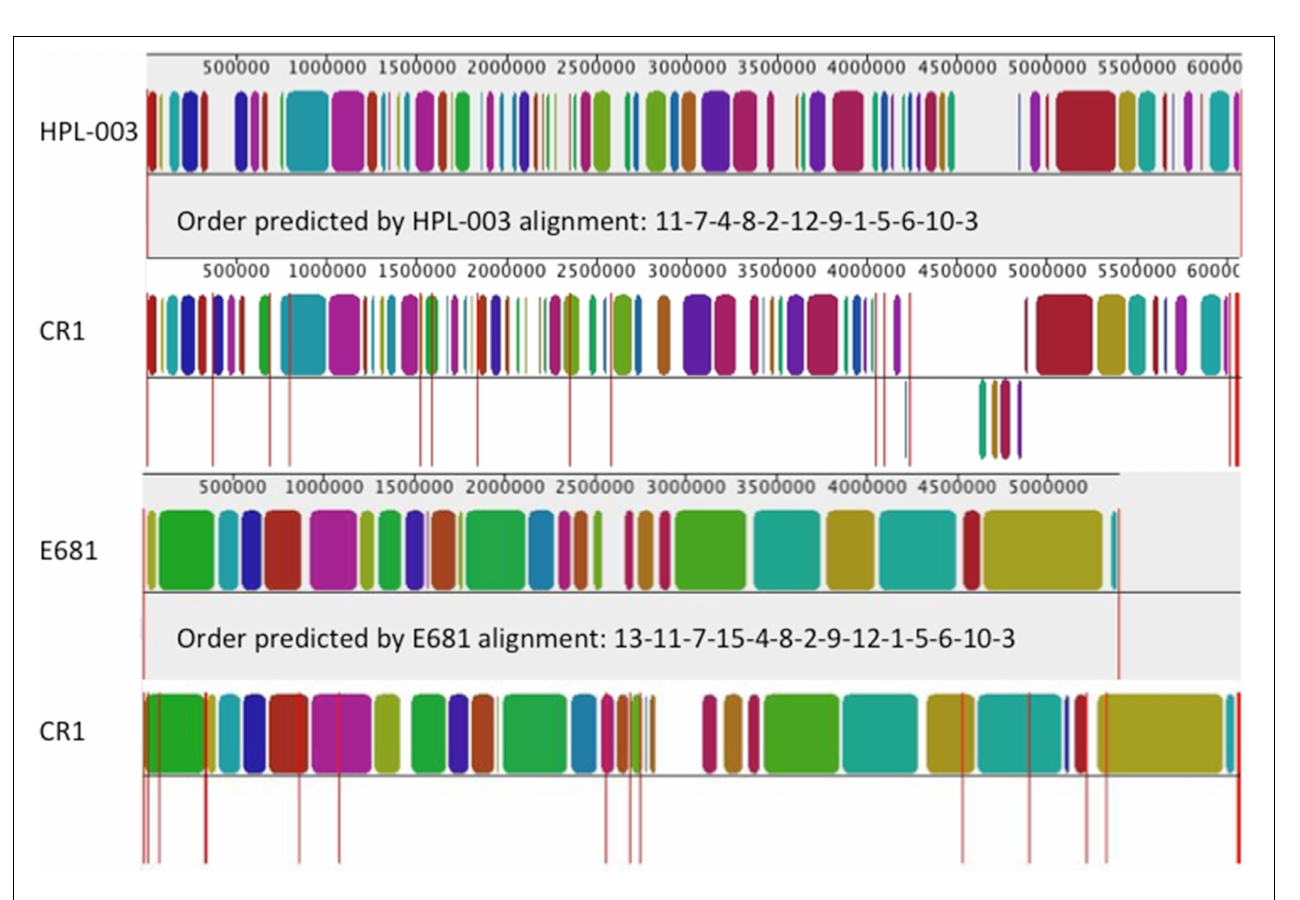
contained within the P. polymyxa strain CR1 draft genome are reordered to approximate the LCB plot of the above completely finished genome. Global alignments are visualized as LCBs, which represent regions with high levels of nucleotide similarity between genomes. LCBs are colored according to homology to LCBs of the compared genome. LCBs drawn below the horizontal correspond to inversions relative to the reference